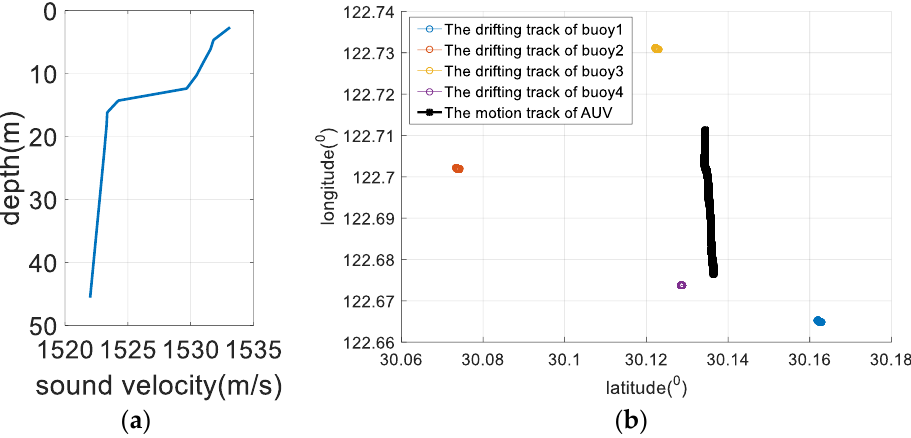
Figure 12. Sea trial conditions. ( a ) The sea trial sound velocity profile; ( b ) the movement trajectory of the AUV and the position of the buoy